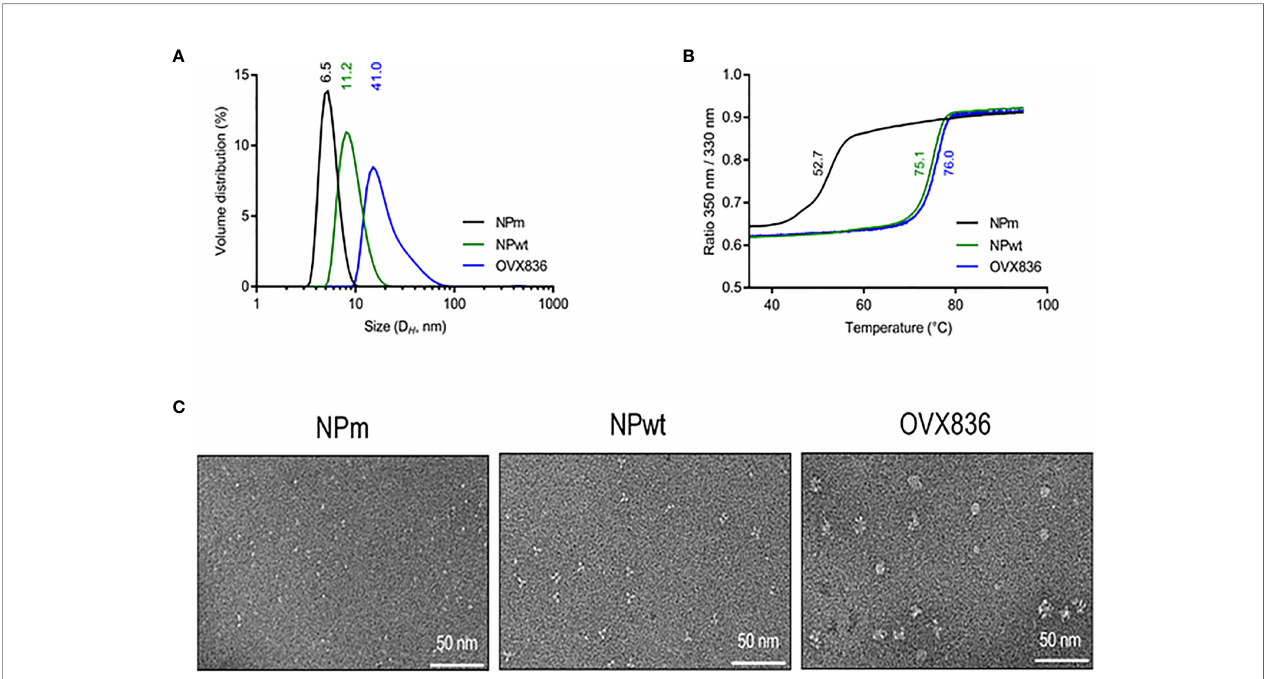
FIGURE 1 | Characterization of in fl uenza A nucleoprotein (NP) constructs. (A) Size distribution as measured by dynamic light scattering (left panel). The x-axis shows a distribution of size classes (nm) and the y-axis shows the relative volume distribution. Hydrodynamic diameters are obtained from scattering intensity DLS distributions. (B) Thermal stability as measured by nano differential scanning fl uorimetry (right panel). The in fl ection temperature (Ti) values are mentioned. (C) Electron microscopy images. NP protein vaccines show different oligomeric